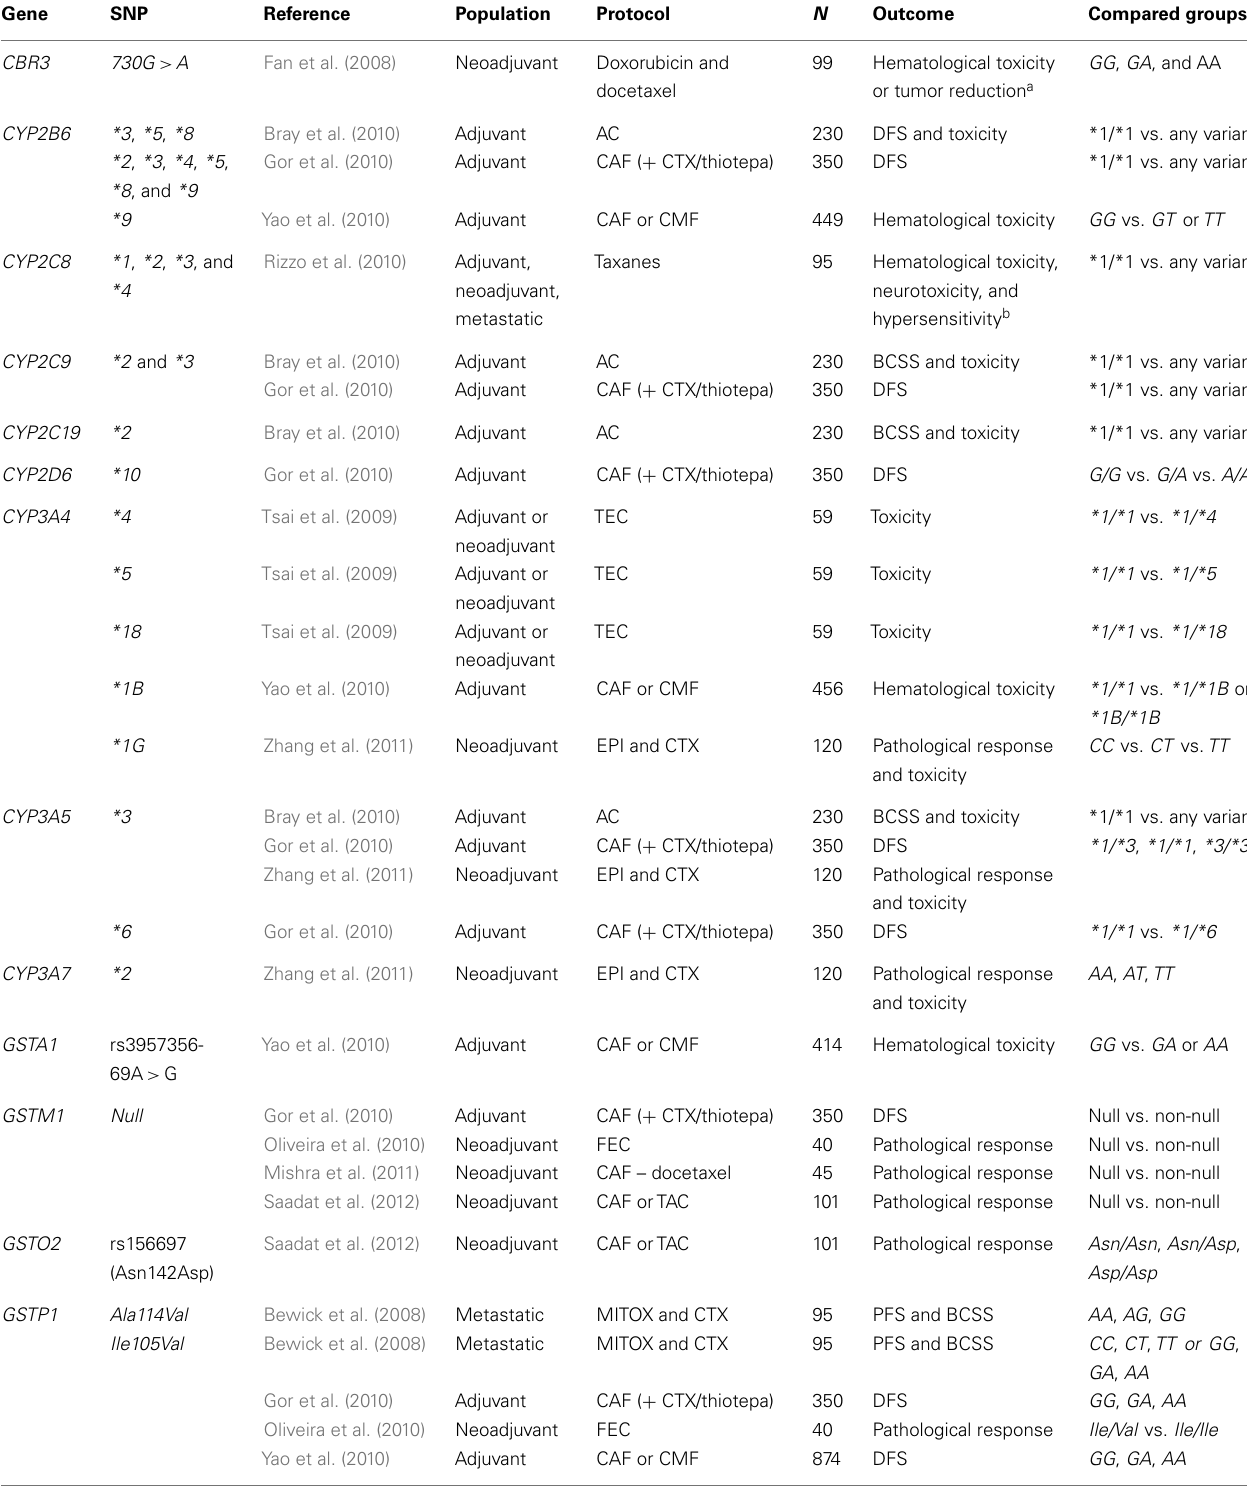
Table 5 | Null associations between polymorphisms in xenobiotic metabolizing enzymes and breast cancer outcomes after